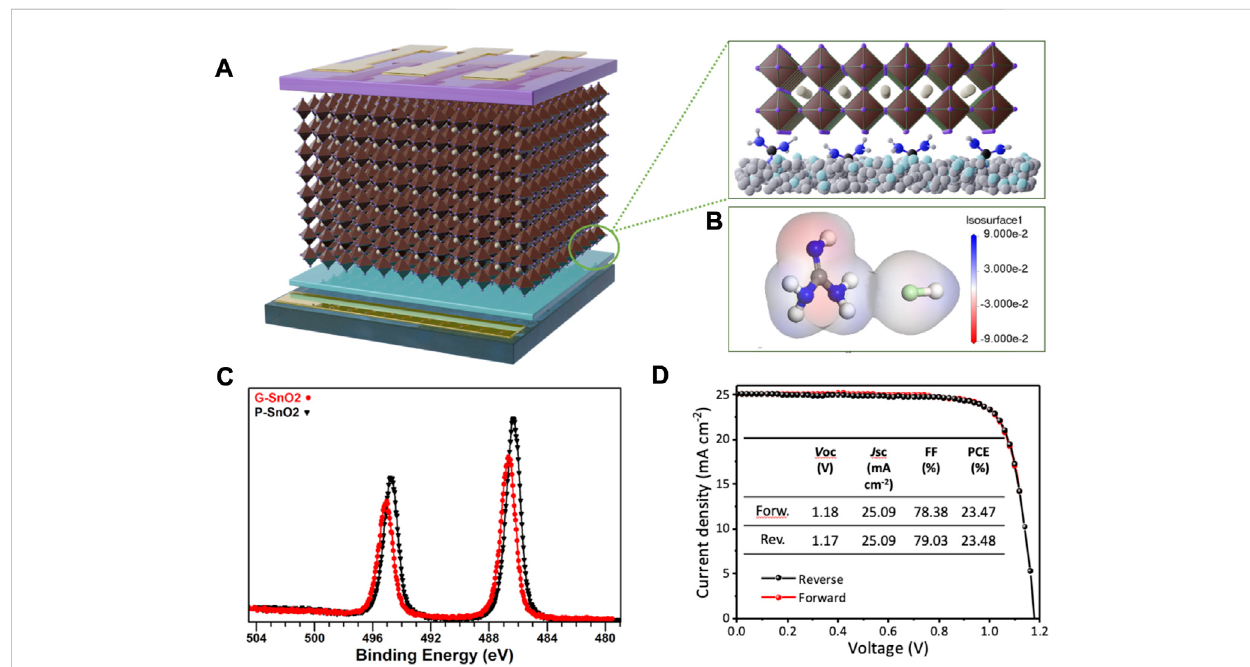
FIGURE 1 (A) Solar cell device architecture consisting of ITO/G-SnO 2 /perovskite/spiro-OMeTAD/Au, and G-SnO 2 /perovskite interface (inset). (B) Calculated ESP pro fi les of guanidinium chloride. (C) XPS analysis of Sn 3d region of G-SnO 2 layer. (D) The best photovoltaic performance characteristics of PSCs using G-SnO 2 ETLs annealed at a low temperature of 80 °